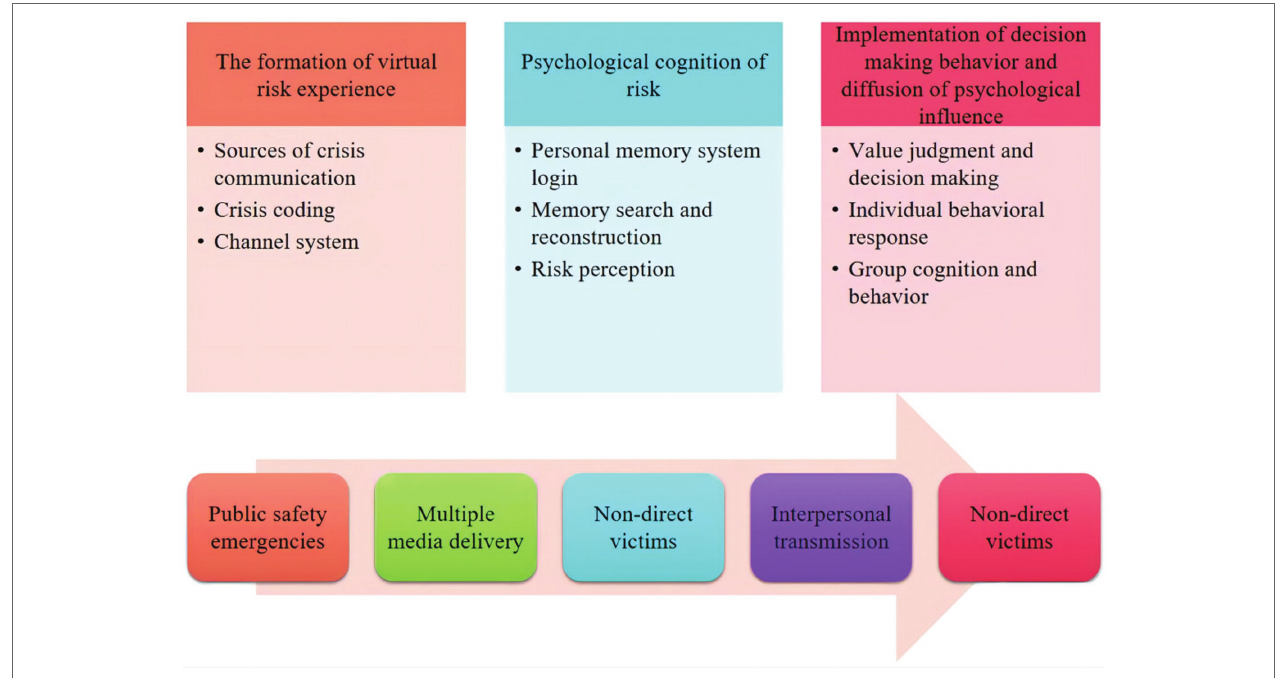
FIGURE 1 | The impact of public safety incidents on public psychology and information dissemination